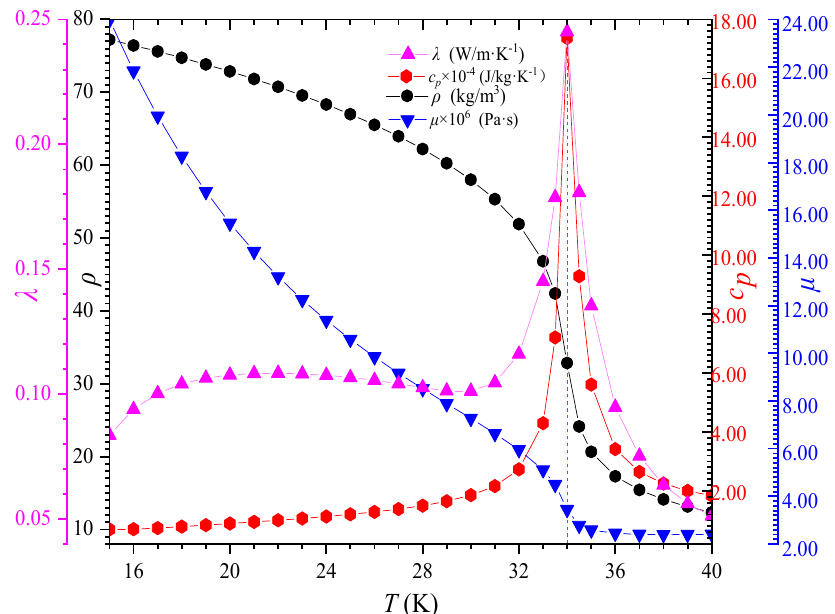
Figure 3. Curve of thermophysical properties of liquid hydrogen with temperature.